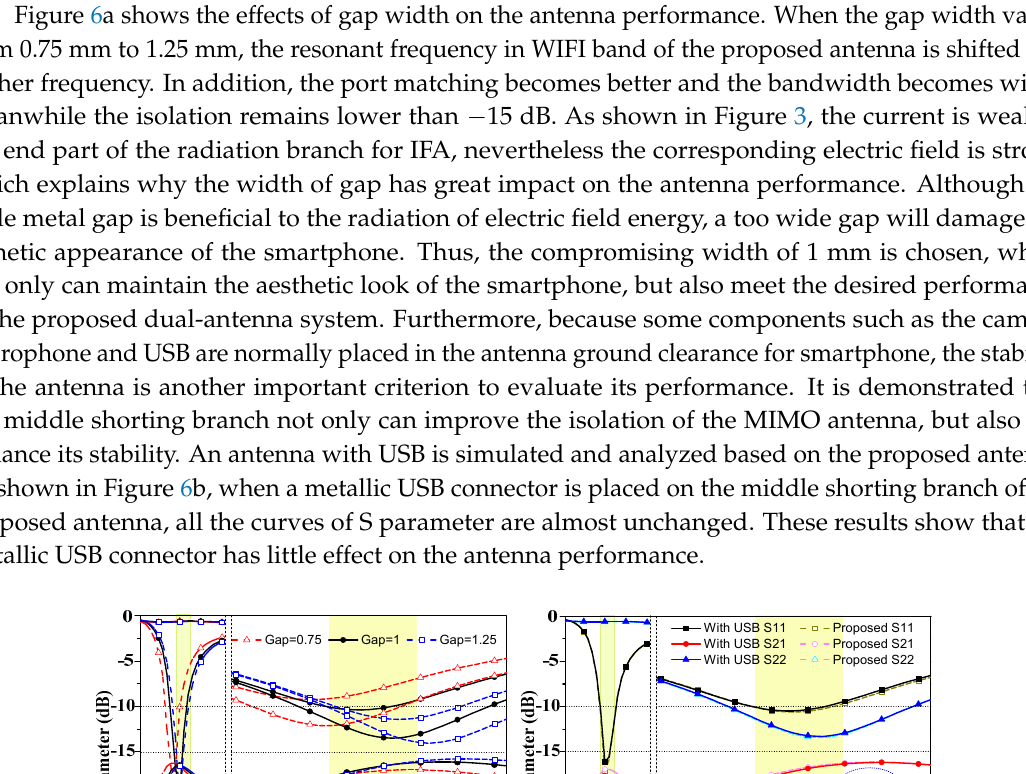
Figure 6. Simulated S parameter for the proposed antenna ( a ) as a function of Gap width, and ( b ) with a USB connector.